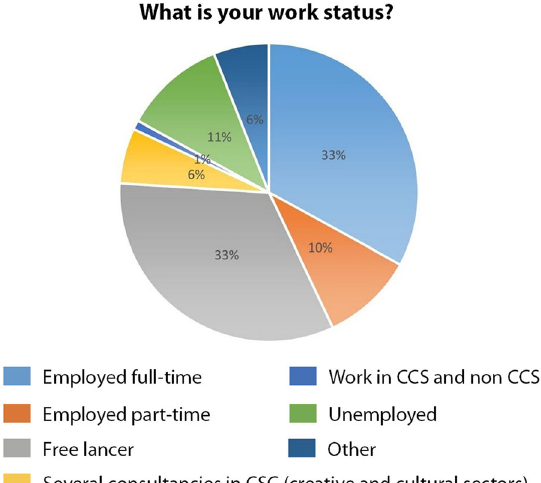
Fig. 11 respondents ’ work status (Source: the